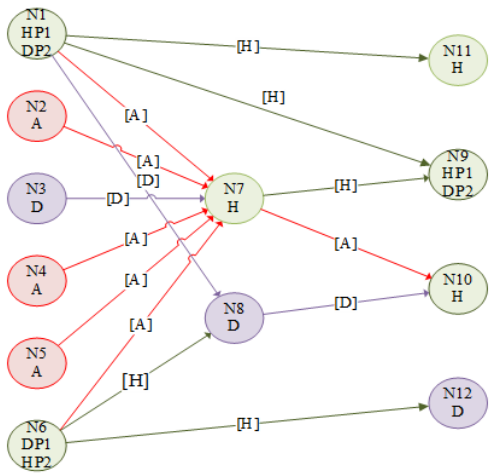
Figure 8. Network representation defender strategy (hardening and deception) as well as for successful attacks. H — hardening, D — deception, A — attack, P1 — crude oil, P2 — NGL.